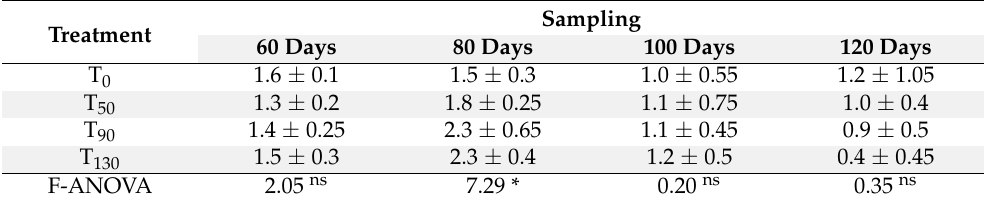
Table 3. Potassium content (mg/L) in leachates. Entries represent means ± standard errors from n = 3 replicates.